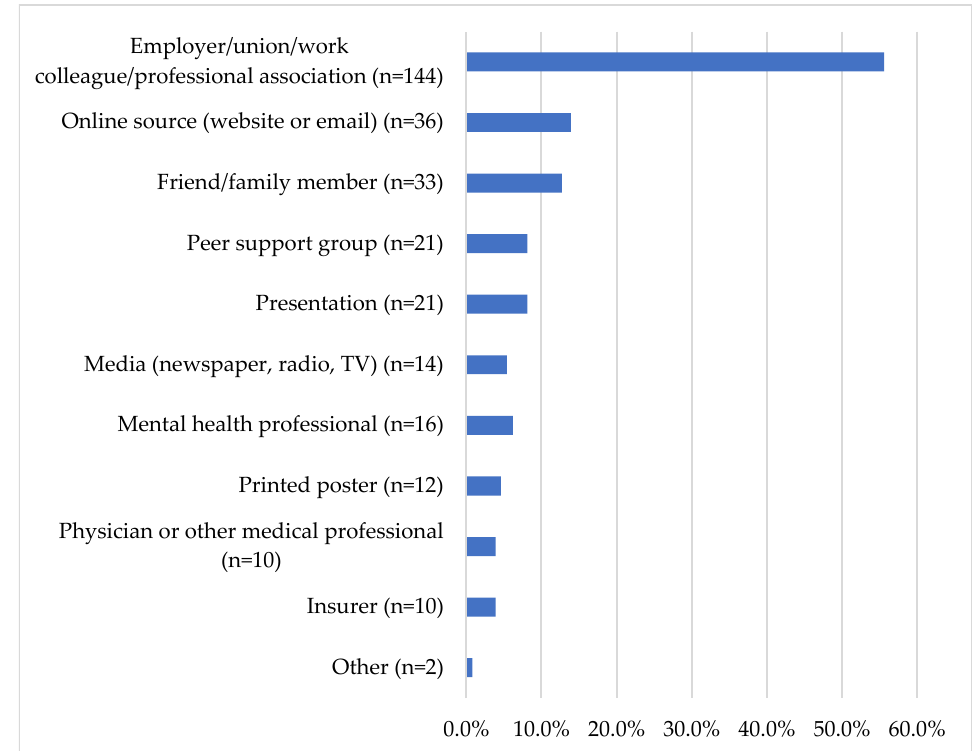
Figure 1. Participant demographic characteristics.